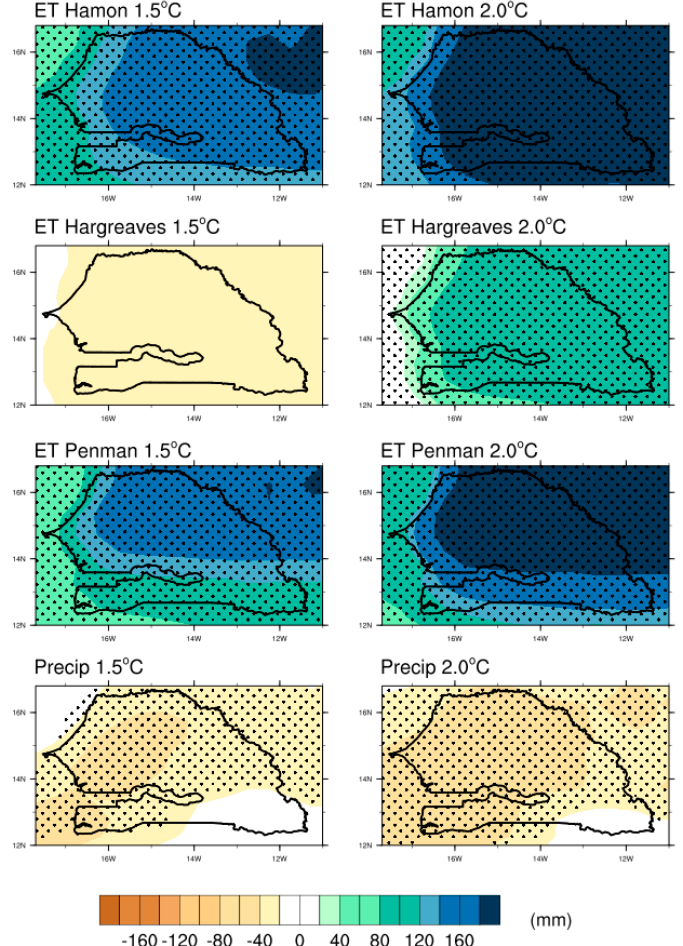
Figure 4. Annual water balance (Pr minus ET, first row: Hamon, second row: Hargreaves, third row: Penman) changes under 1.5 °C ( left column ) and 2.0 °C ( right column ) GWLs. Statistically significant changes (Student’s t -test) at 95% confidence level are represented by black dots.